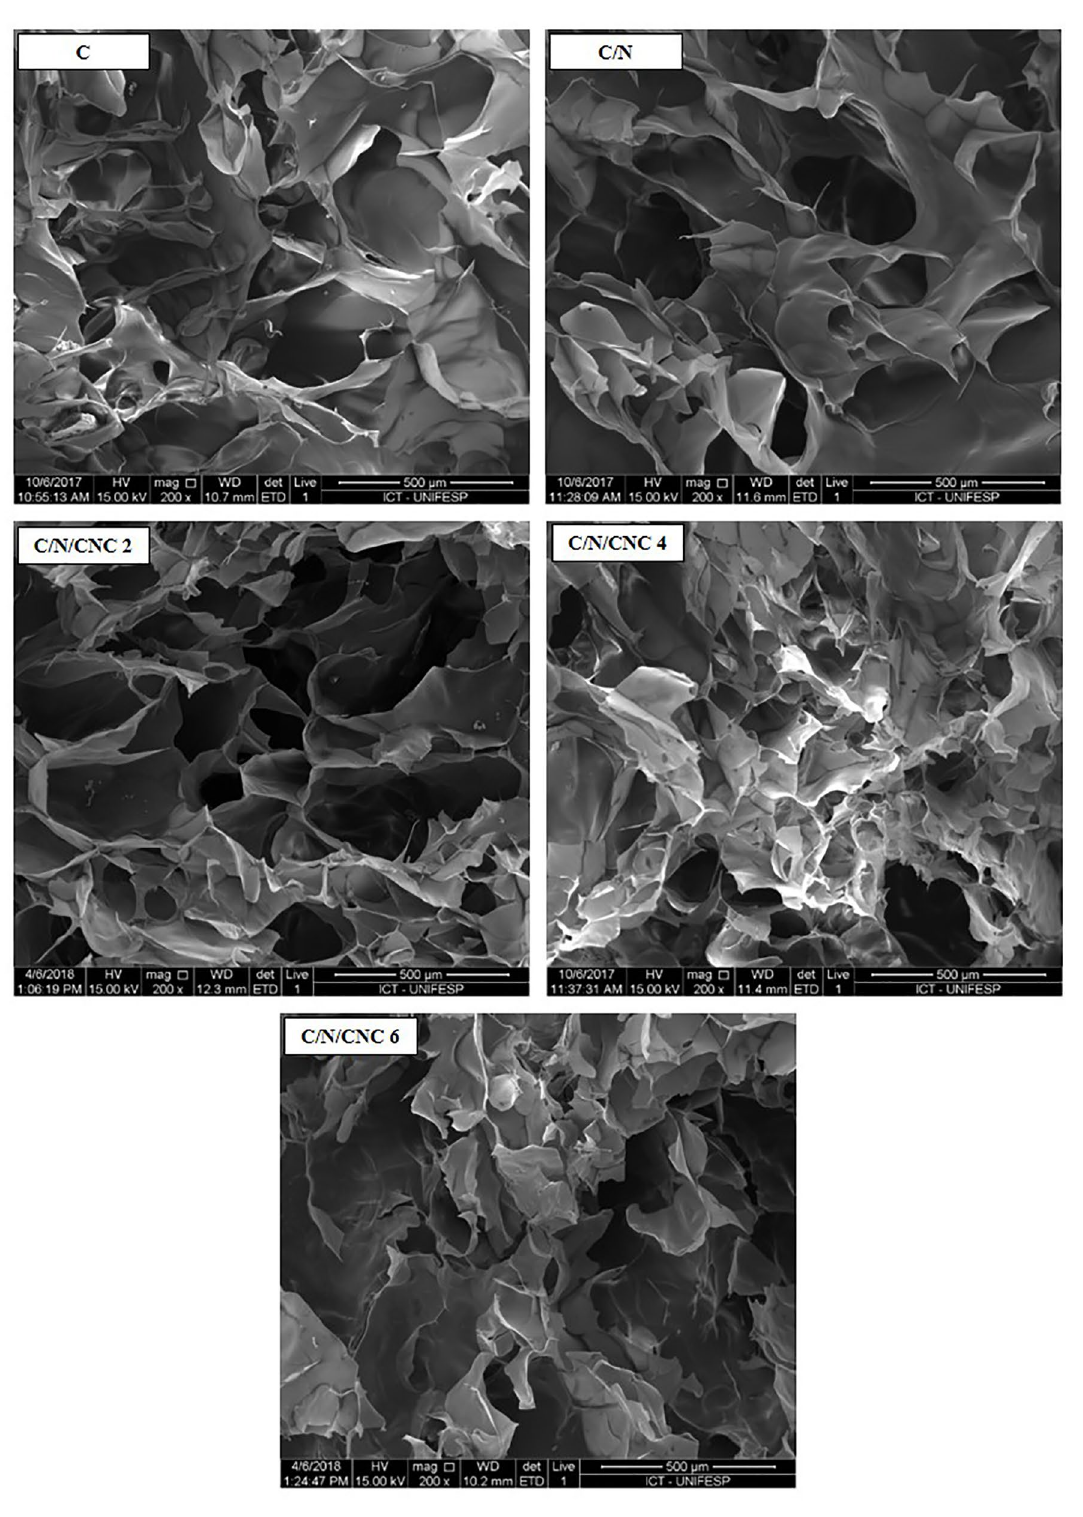
Figure 6. Fracture surface micrographs of chitosan hydrogels. Magnification of